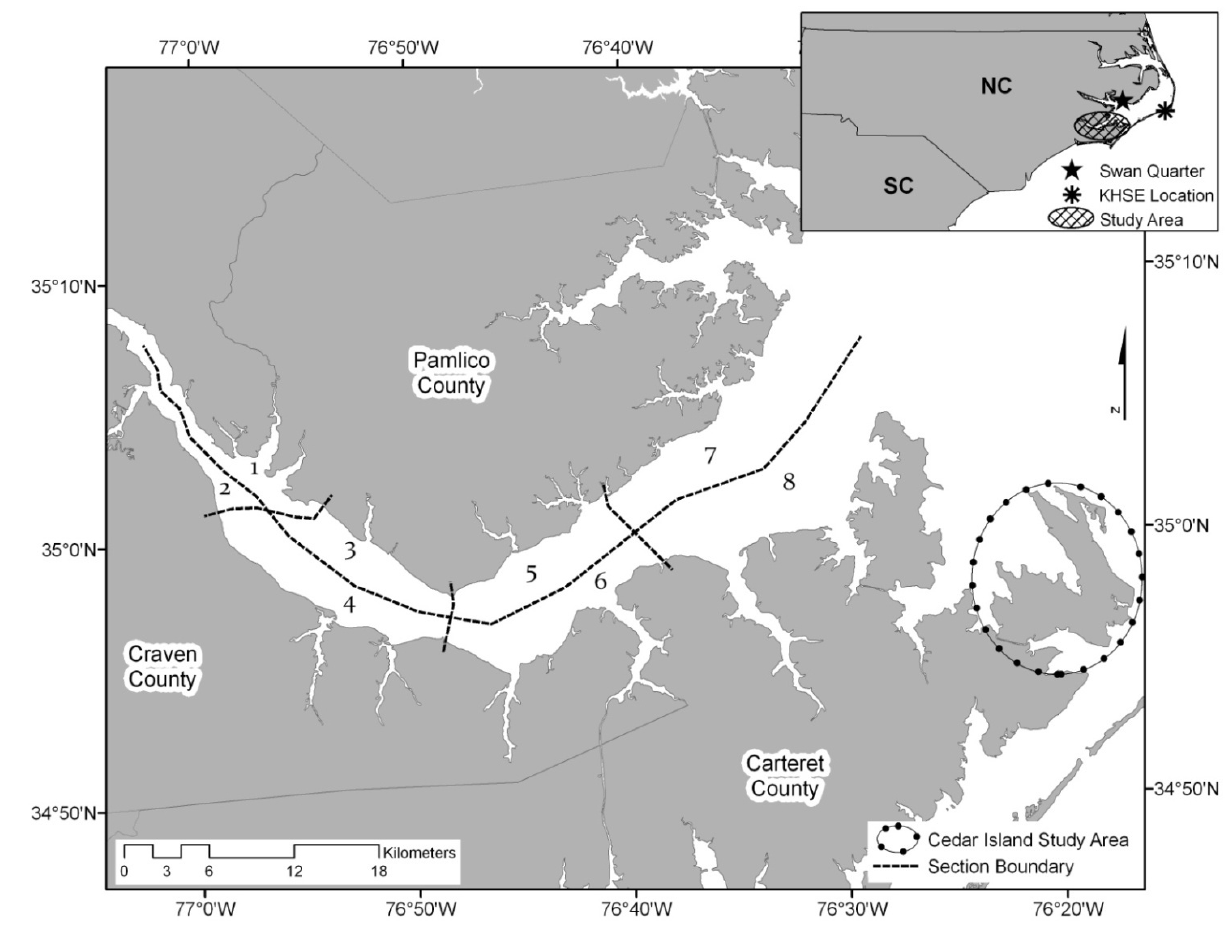
Figure 1. Location map of Neuse River Estuary study area located in North Carolina (inset). Meteorological data were obtained from the KHSE site (inset). The dashed line and corresponding numbers refer to the Local Scale